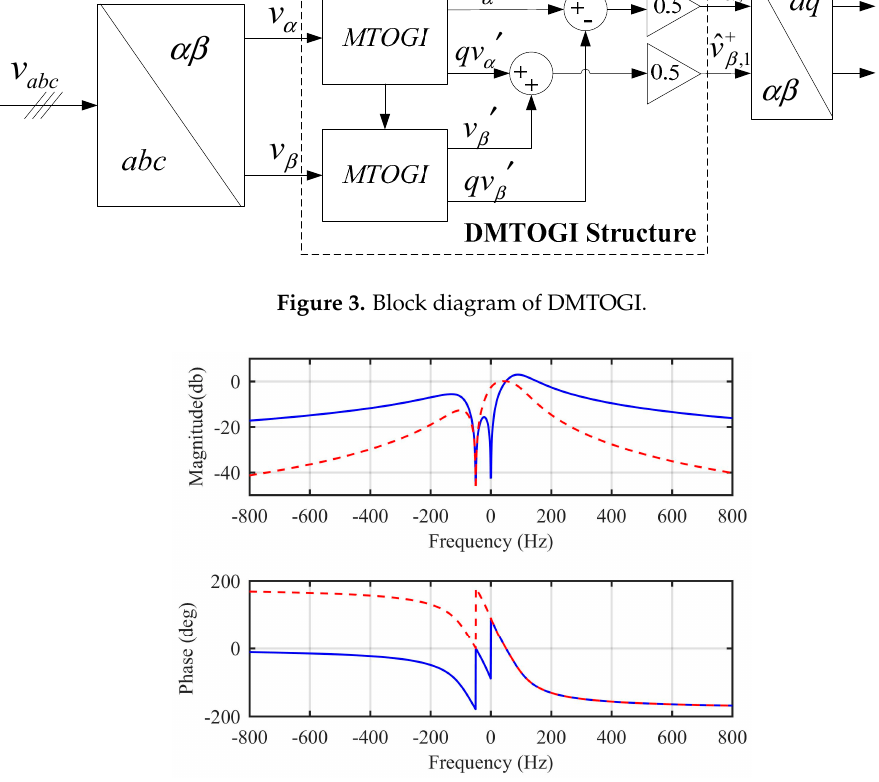
Figure 4. Bode diagram of αβ DMTOGI and DTOGI.